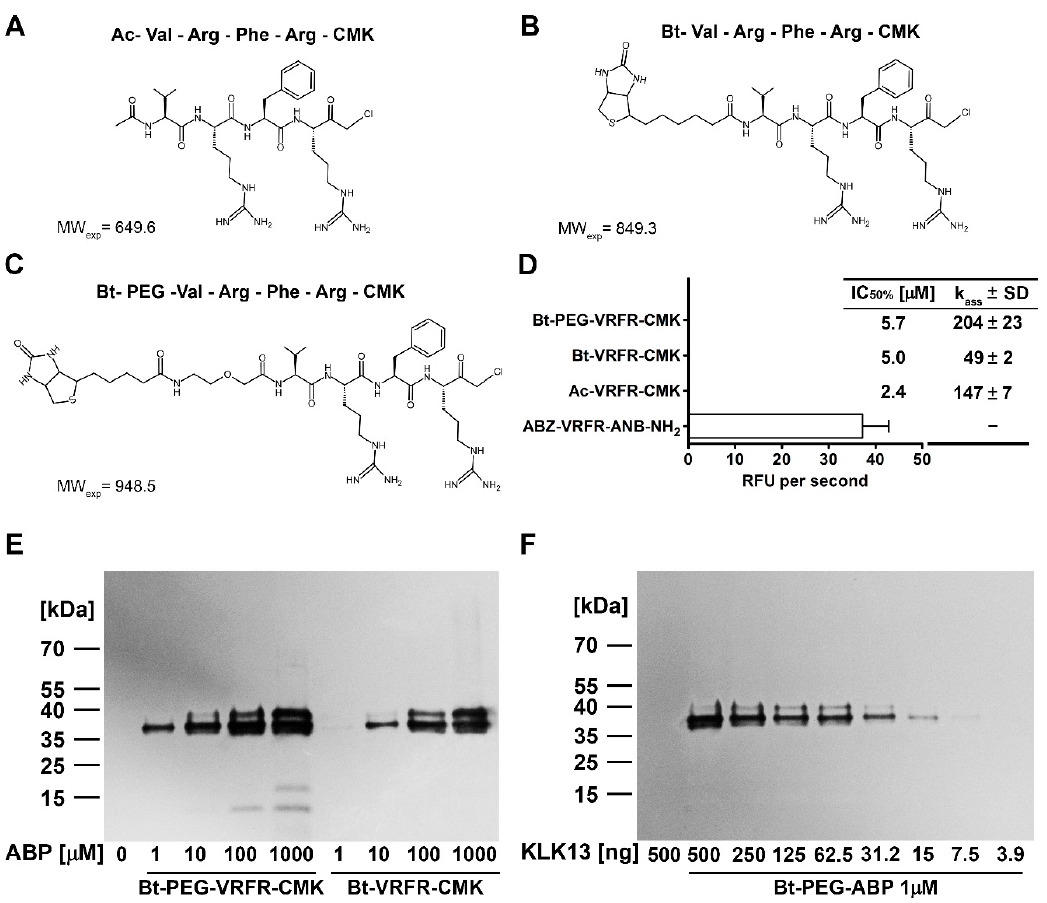
Figure 3. Structure and activity of the KLK13 activity-based probes. ( A – C ) Chemical structures of the optimized compounds developed for KLK13; ( D ) Inhibitory activity of activity-based probes against KLK13. Residual activity of KLK13 was determined in triplicates using Abz-VRFR-ANB-NH 2 after preincubation with tested ABPs. Kinetic parameters (k ass (M − 1 · s − 1 )) were determined by the progress curves method and are shown as mean ± SD from three replicates. The IC 50 values were determined by linear regression to the initial fragment of the KLK13 activity vs concentration of the given inhibitor curve; ( E ) Biotin-conjugated ABPs specific for KLK13 were tested for protease detection in Western blot analysis. 250 ng of KLK13 was incubated with ABPs at indicated concentrations in TNET buffer for 1 h at 37 °C. ABP with a polyethylene glycol (PEG) linker showed higher sensitivity in comparison to the shorter version of the probe, allowing for KLK13 detection at 1 μ M concentration and better discrimination between pro- and active KLK13 (observed as the higher molecular weight band); ( F ) Detection limit of KLK13 at an optimized probe concentration. Twofold serial dilutions of KLK13 in the range of 500 to 4 ng were incubated with 1 μ M Bt-PEG-VRFR-CMK ABP in TNET buffer for 1 h at 37 °C. Labeling was detected by Western blot. The detection limit is estimated at 15 ng of purified KLK13.